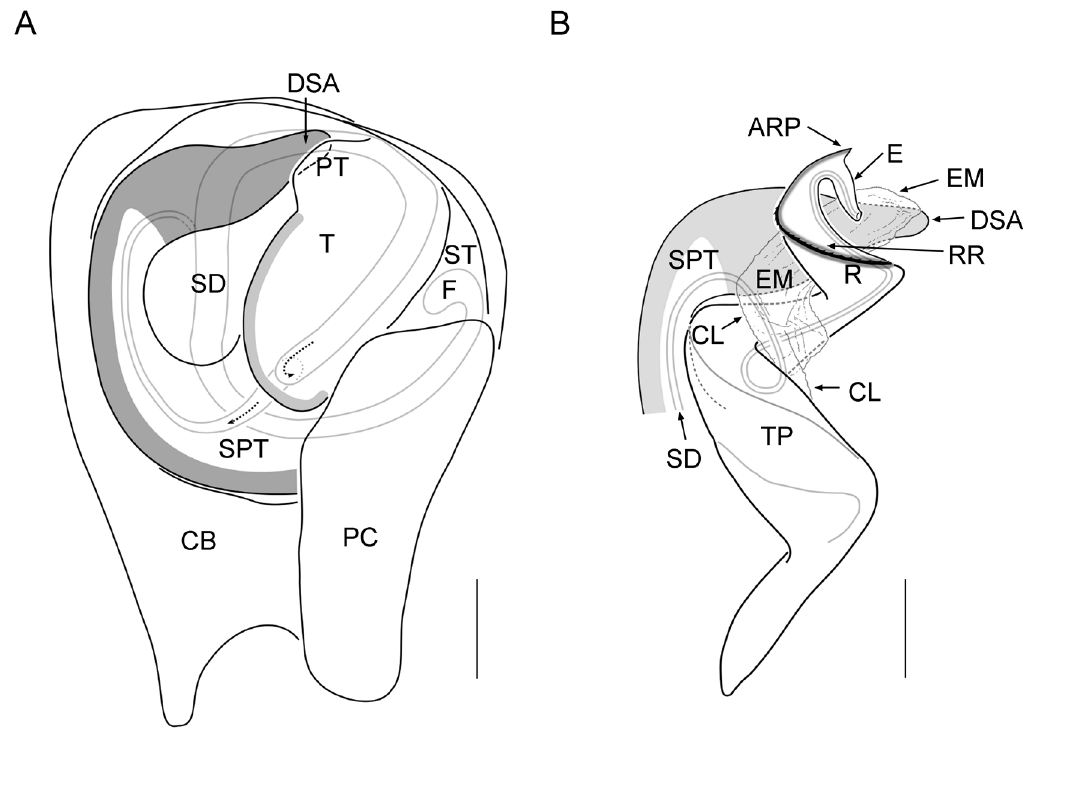
Fig. 3. Xim trenzado gen. et sp. nov., male left palpus, schematic. A . Palpus without embolic division, ventral view. B . Embolic division with part of distal suprategular apophysis, ventral view. Scale bars: A = 50 μm; B = 40